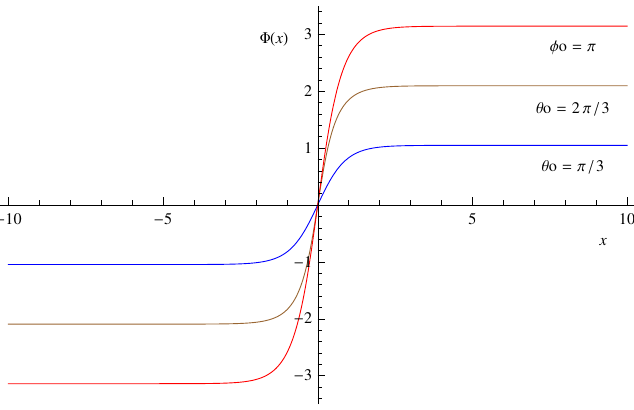
Figure 8 . The analytical kinks Φ( x ) for the set of parameters κ = 1 , β = 1 , θ 0 = { 2 π/ 3 , π/ 3 } , φ 0 = π . The kink with φ 0 = π value will host a Majorana